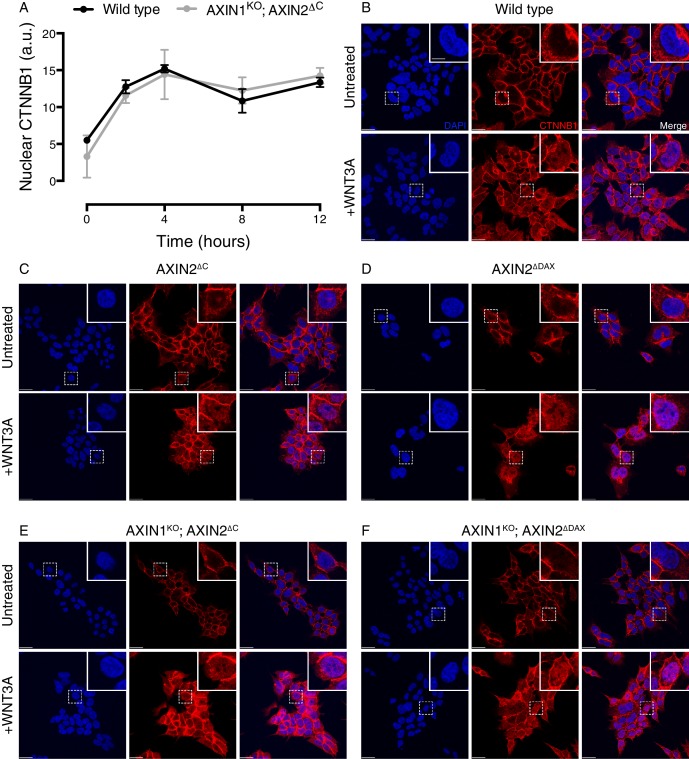
Cells lacking the C-terminal DAX domain of AXIN2 exhibit normal CTNNB1 nuclear accumulation following WNT treatment.(A) Kinetics of CTNNB1 nuclear accumulation following treatment with 50% WNT3A CM. Nuclear CTNNB1 (average nuclear fluorescence per unit area from three fields of view in a.u.) was quantified as described in Materials and methods. In all subsequent experiments, nuclear CTNNB1 was measured following 4 hr of treatment with WNT3A. (B–F) Single confocal sections though the center of the nucleus for the indicated cell lines, stained with DAPI (left images), immunostained for CTNNB1 (center images) and merged (right images). All images for a given channel were acquired using identical microscopy settings, and brightness and contrast was adjusted equally for display purposes. Cells were treated with 50% WNT3A CM for 4 hr where indicated. Representative regions demarcated by dashed squares ware magnified 3x and are shown in the insets. Scale bar = 18 μm in the main images, and 6 μm in the insets.